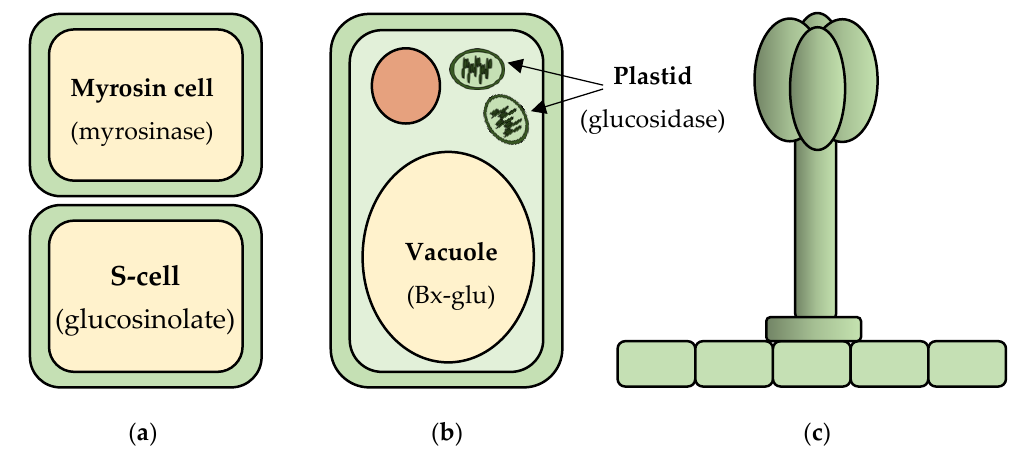
Figure 1. Mechanisms for isolation and activation of phytoanticipins. ( a ) In glucosinolate containing plants, the glucosinolates are stored in the vacuoles of sulfur rich S-cells and their activating myrosinase enzymes in adjacent myrosin cells. Tissue rupture during herbivory leads to the mixing of the components of the two cell types and glucosinolate activation; ( b ) In benzoxazinoid containing plants, the benzoxazinoids are stored as glucose conjugates (Bx-glu) in the vacuoles, and their activating glucosidase enzymes are stored in the plastids of the same cell. Cell rupture during herbivory leads to removal of the glucose moiety by the glucosidase and release of the active aglycone; ( c ) Glandular trichomes are found on a range of species and are specialized secretory or storage cell structures on the epidermis that physically separate defense molecules from the plant tissues and aid in their exposure to the attacking insect or surrounding environment.